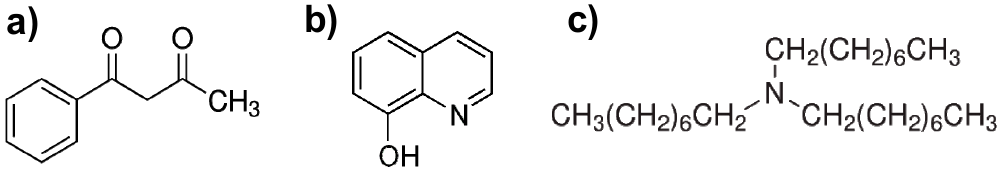
Figure 1. Chemical structure of carriers used in this study ( a ) benzoylacetone; ( b ) 8-hydroxyquinoline; ( c ) tri- n